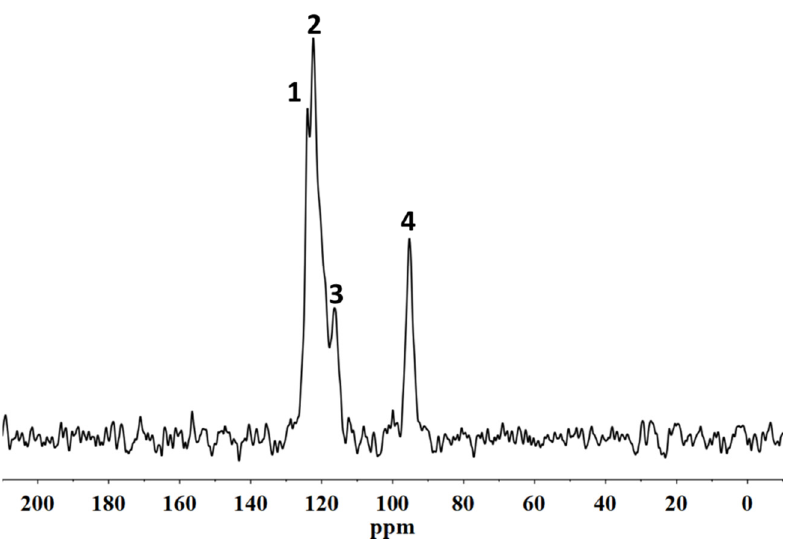
Figure 6. 13 C{ 19 F} CP − MAS NMR spectrum of Fluoline HY film. Table 2. Assignment of the chemical shift of 13 C{ 19 F} CP-MAS spectrum.